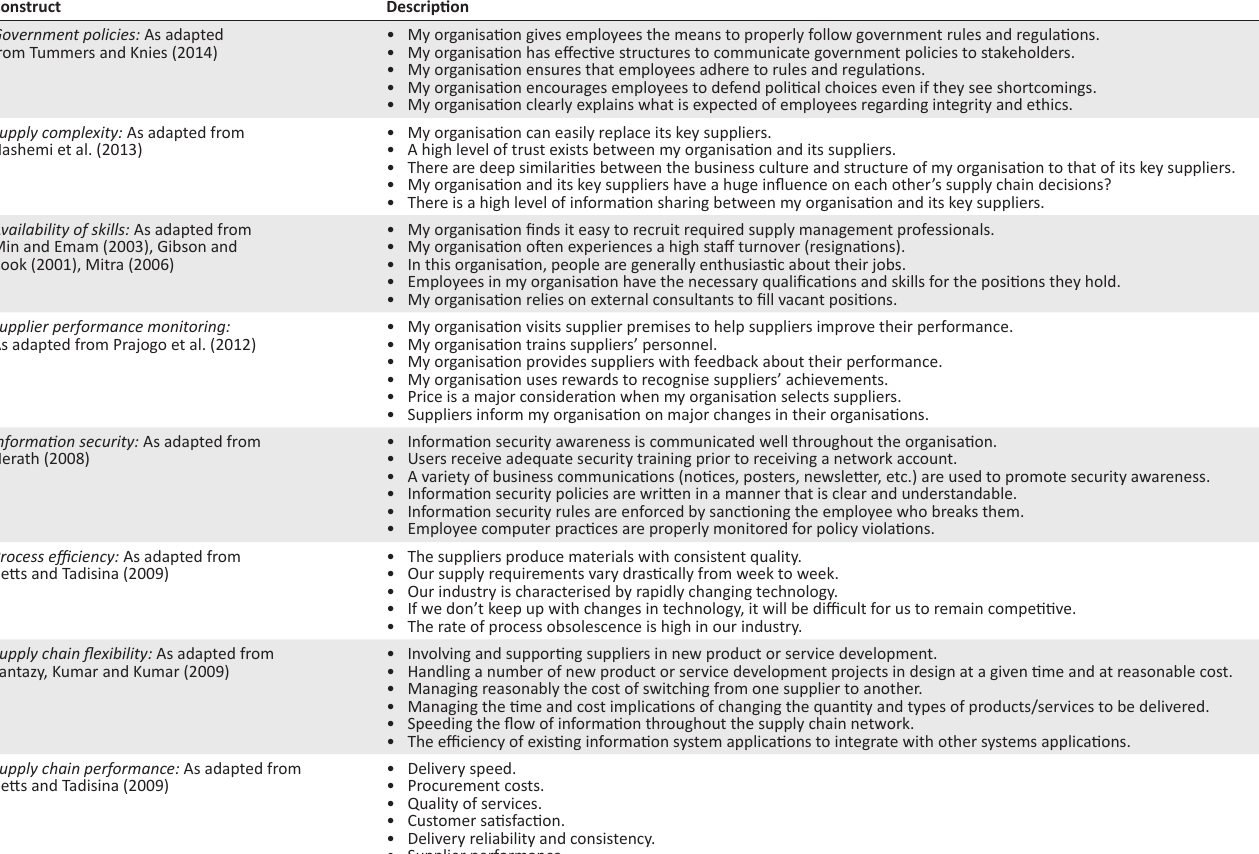
TABLE 1: Measurement scales and their sources. Construct